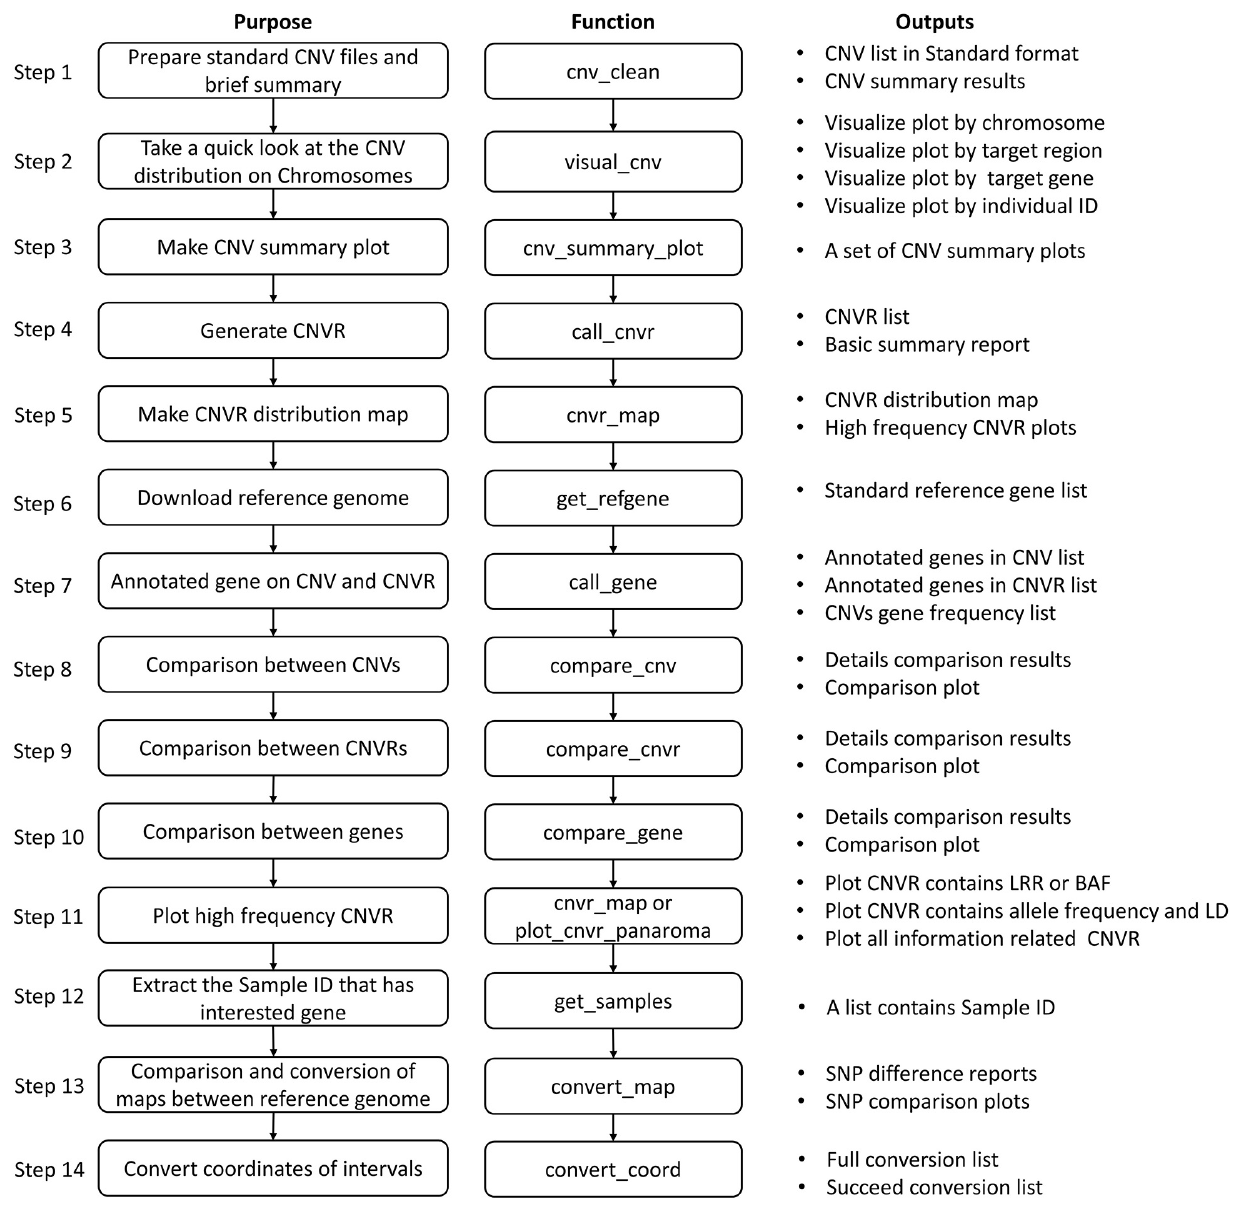
FIGURE 2 | Pipeline of post analysis of CNV results using